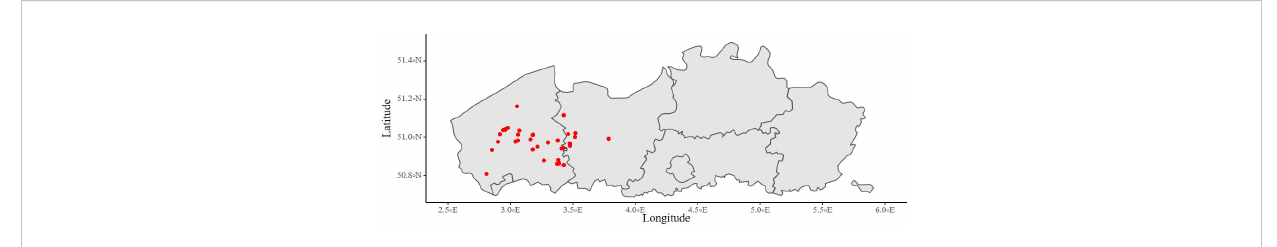
FIGURE 1 All fi eld locations monitored of cauli fl ower and spinach in Flanders during the growing seasons of 2019, 2020 and